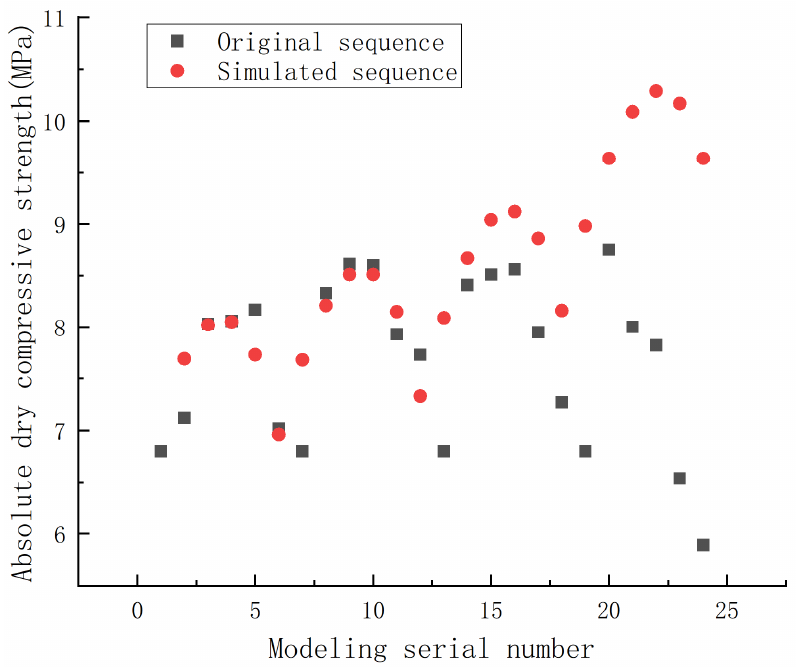
Figure 4. Comparison of the original sequence and the simulated sequence in absolute dry compres- sive strength of the phosphorus building gypsum modified by ball milling. The average relative simulation error of the calculated NSGM (1,4) model of absolute dry compressive strength was 13.77%, as shown in Table 7. Table 7. Error of absolute dry compressive strength simulation results.